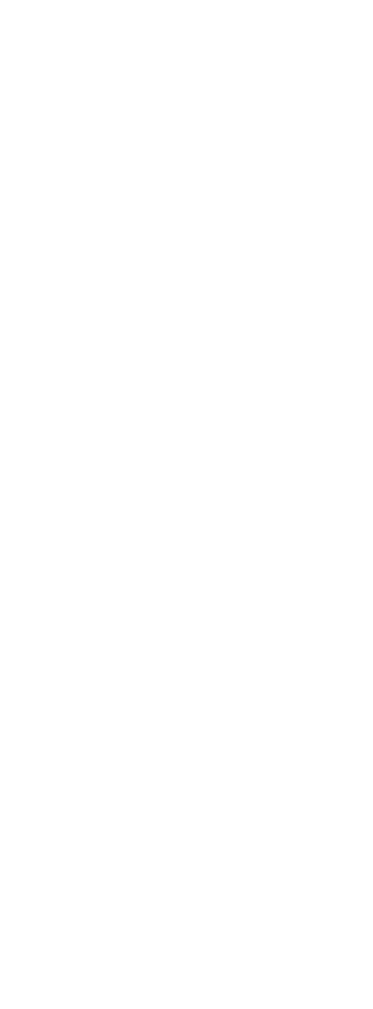
FIGURE 4 The training and testing losses when predict the next 6 hours in station 2.